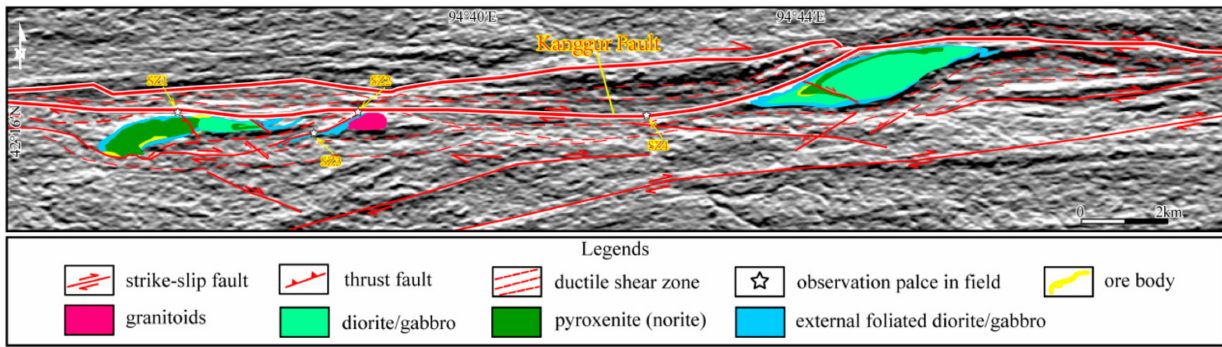
Figure 8. Structural interpretation of ASTER GDEM overlapping ore bodies and interpretation of lithological mapping in the study area [53]. The thick red line shows the Kanggur Fault. The thin red lines show the secondary faults. Red dashed lines show the ductile shear zone. White stars represent observation sites of Unmanned Aerial Vehicle ( UAV) images and detailed photographs of the Huangshan shear